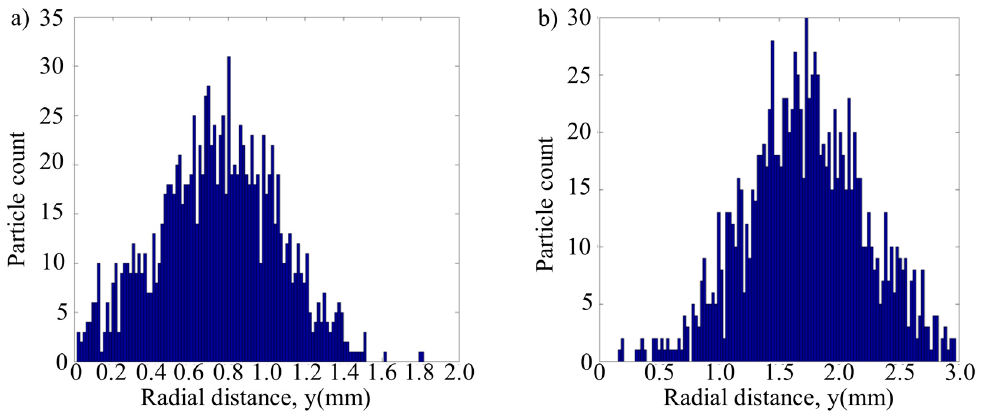
Figure 11. Statistical chart of powder quantity. ( a ) Powder quantity in laser DED and ( b ) powder quantity in the hybrid process.